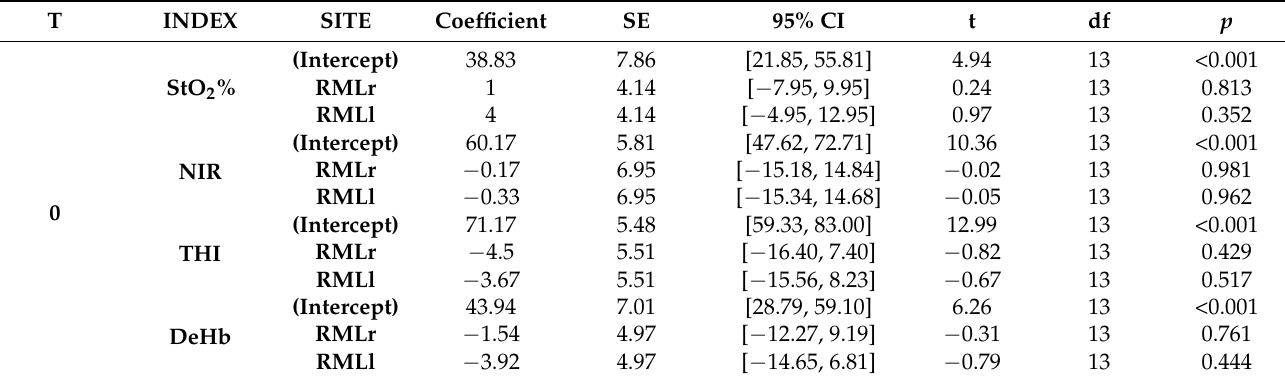
Table 2. Mixed-effects linear regression to estimate the variations of the hyperspectral indexes among different liver lobes. In this table, the reference level is the right lateral lobe after the exclusion of the left lateral